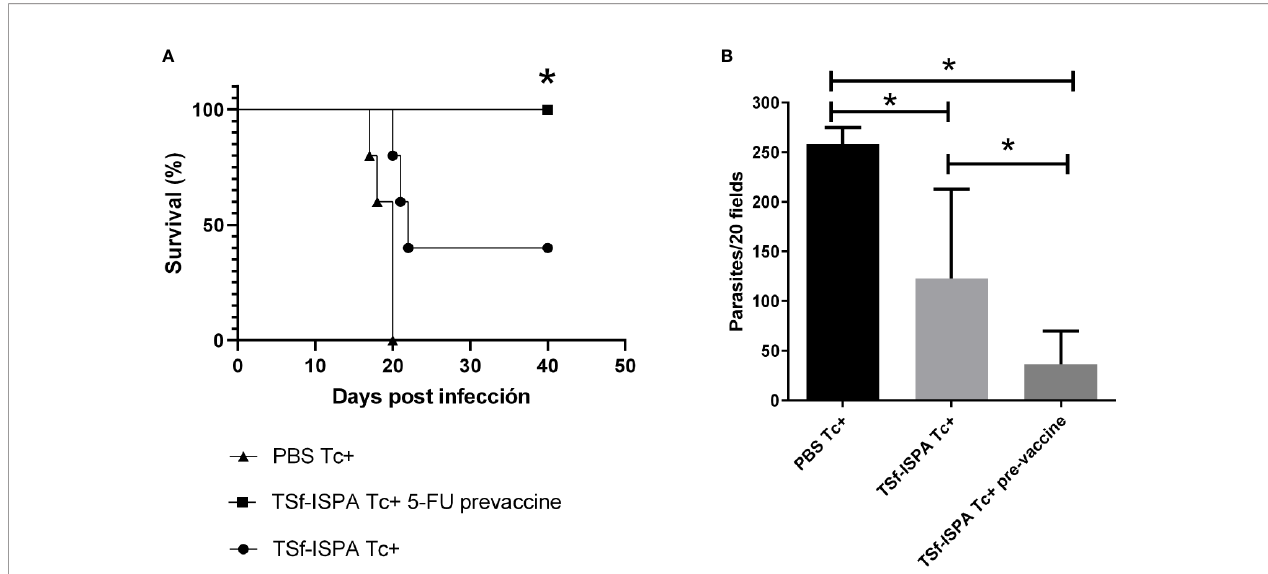
FIGURE 7 | 5FU treatment one day before each dose of TSf-ISPA vaccine. Mice immunized with TSf-ISPA or PBS were treated or not with 5FU one day before each dose of TSf-ISPA vaccine and then were challenged with 1500 trypomastigotes of the Tulahuen strain. (A) Survival rates are shown for PBS-inoculated and infected mice (PBS Tc+), TSf-ISPA immunized and infected mice (TSf-ISPA Tc+), and TSf-ISPA mice that received 5FU one day before each dose of the vaccine (TSf-ISPA Tc+ 5FU pre-vaccine), (B) Parasitemia at day 20 p.i. from PBS Tc+, TSf-ISPA Tc+, and TSf-ISPA Tc+ 5FU pre-vaccine. The results are representative of two independent experiments (n =5 mice per group. *p < 0,05 between indicated groups of